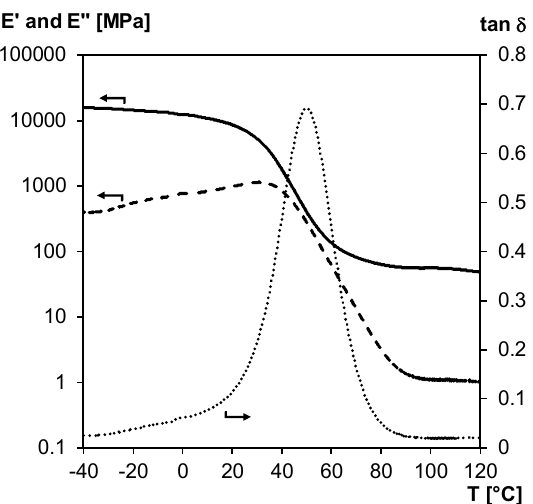
Figure 12. DMA of 3M-F375PMA network film measured in tension mode. Storage modulus E’ ( full line ), loss modulus E” ( dashed line ) and tan δ ( dotted line ).